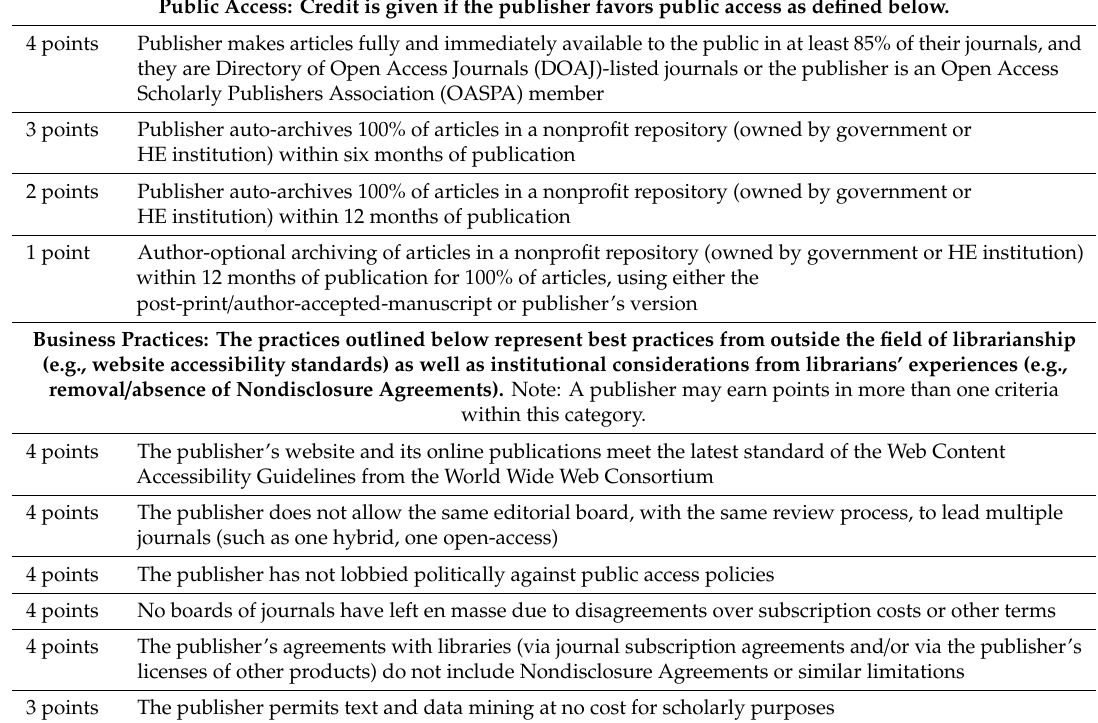
Table 1. How points are awarded in two of the ten Publishers Acting as Partners with Public Institutions of Higher Education and Land-grant Universities (PAPPIHELU, or PAPPI) categories. See Appendix A for